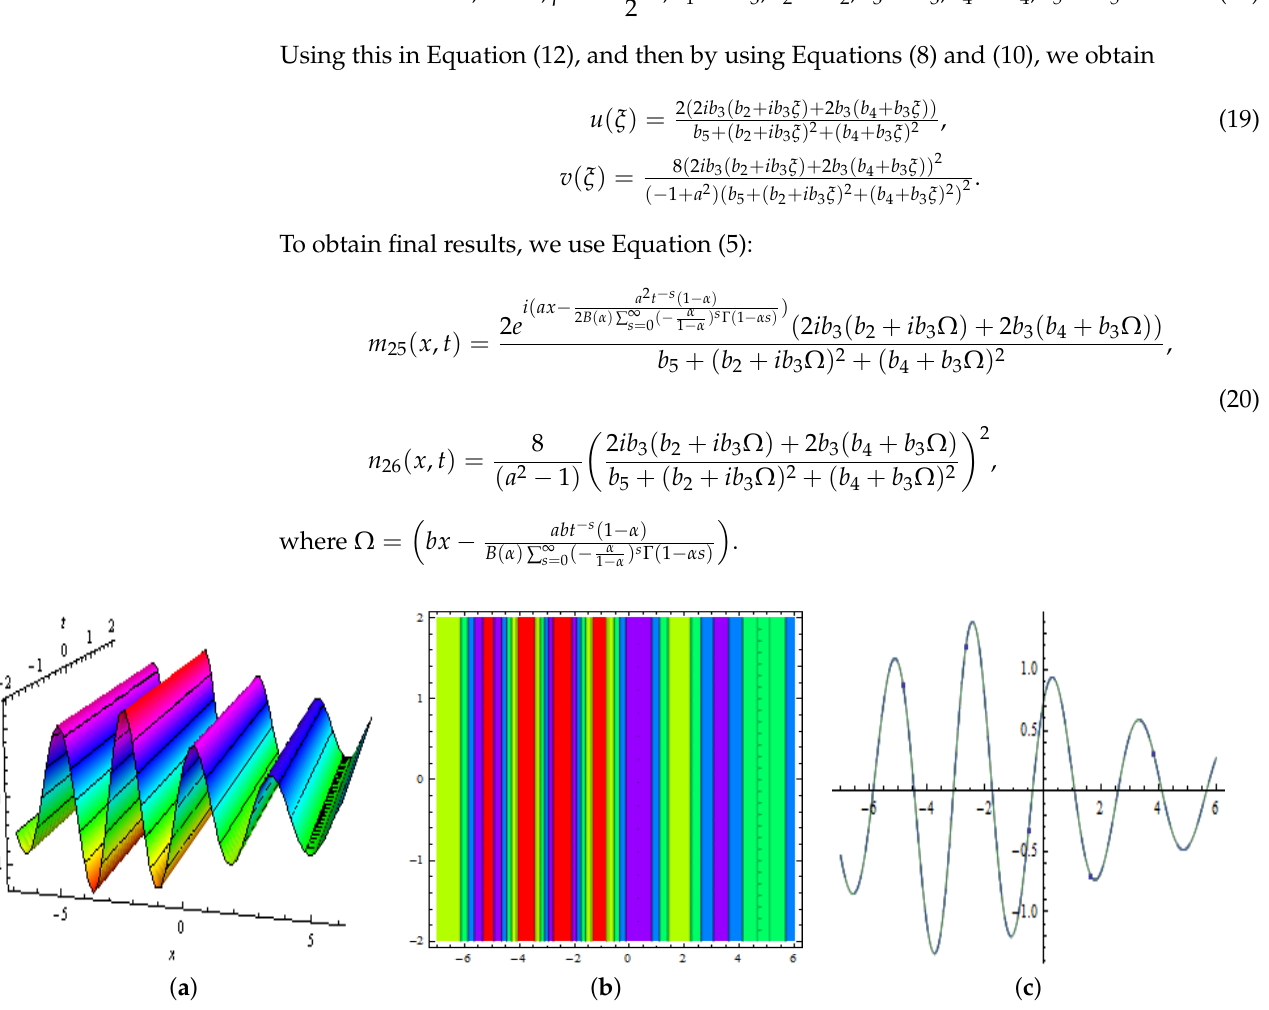
Figure 2. represented three-dimensions in ( a ); contour in ( b ) and two-dimensions in ( c ), Plots of m 25 ( x , t ) in Equation (20) for a = 2, b = 0.5, b 2 = − 3, b 3 = 1, b 4 = 3, b 5 = − 1, α = 0.8,